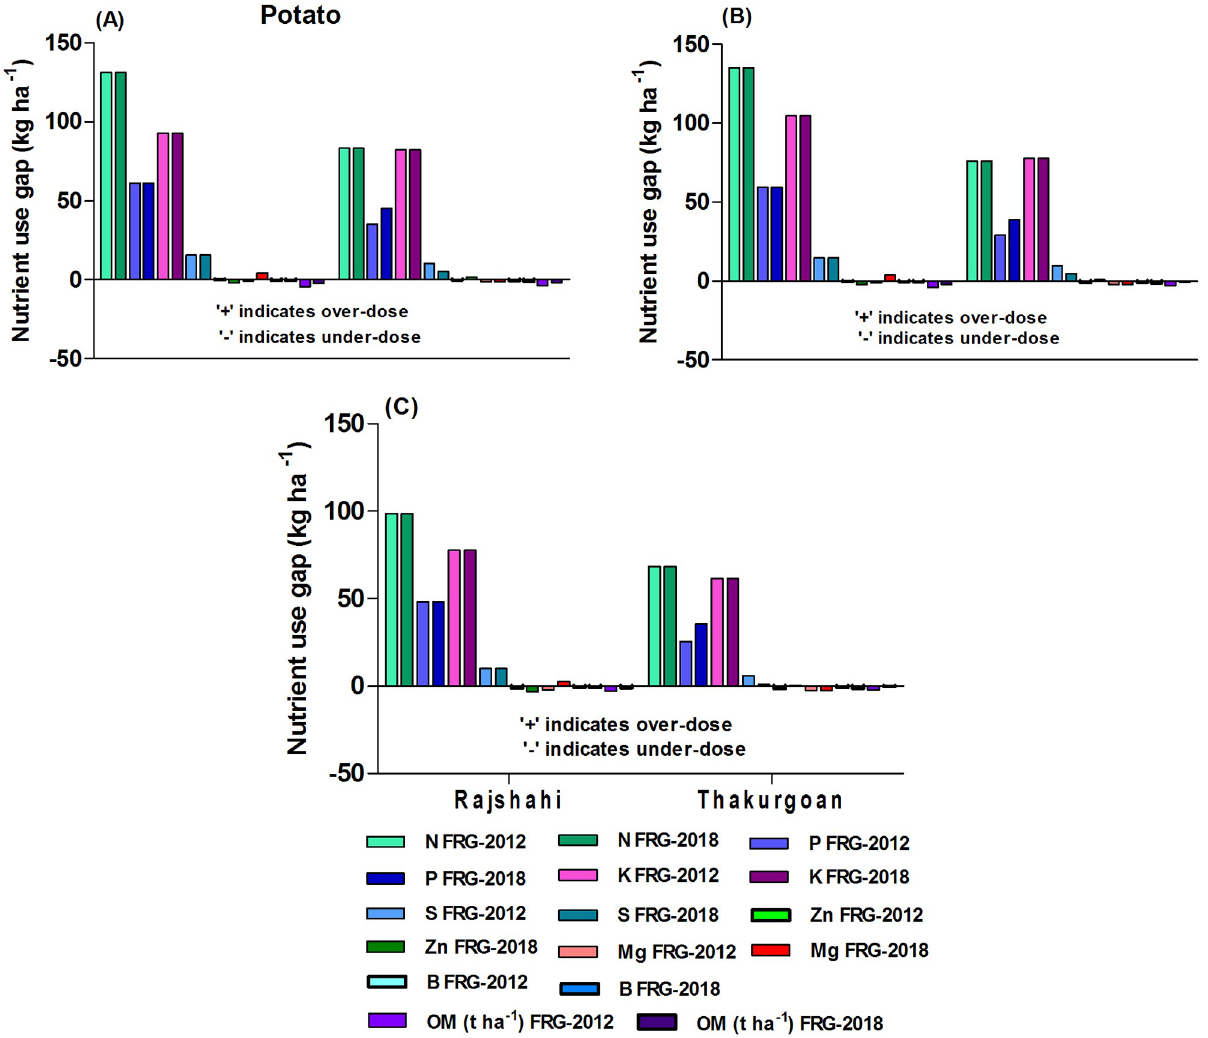
Fig 3. Farms’ current nutrient use gaps relative to FRG-2012 and FRG-2018 for potato: A) large-scale farms B) medium-scale farms C) small- scale farms for the potato-maize-monsoon rice cropping pattern.